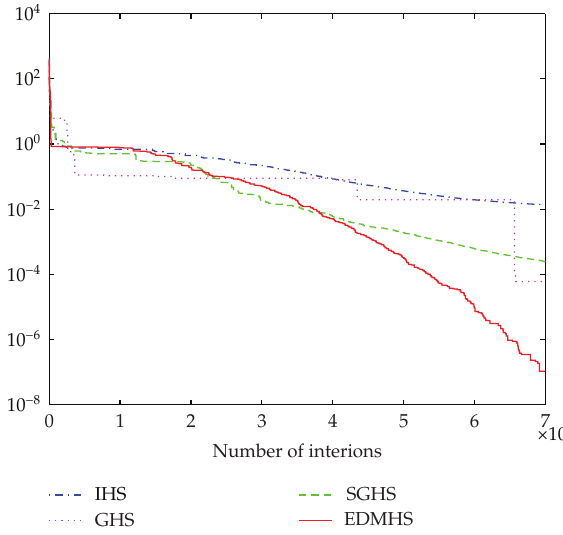
Figure 4: Convergence of Wood